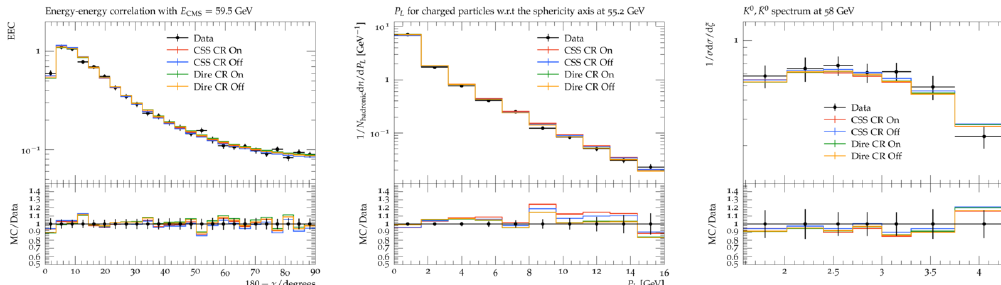
Figure 19: S HERPA results compared with data for the energy-energy correlation (left, from T OPAZ [ 80 ] ), longitudinal moment w.r.t. the sphericity axis (centre, from A MY [ 78 ] ) and the scaled momentum spectrum for neutral kaons (right, from T OPAZ [ 81 ]